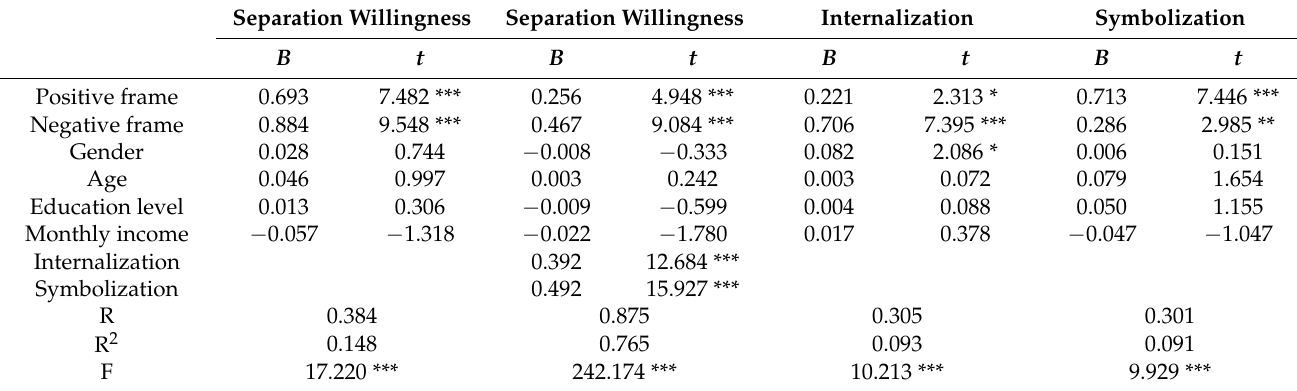
Table 5. Mediation model test.